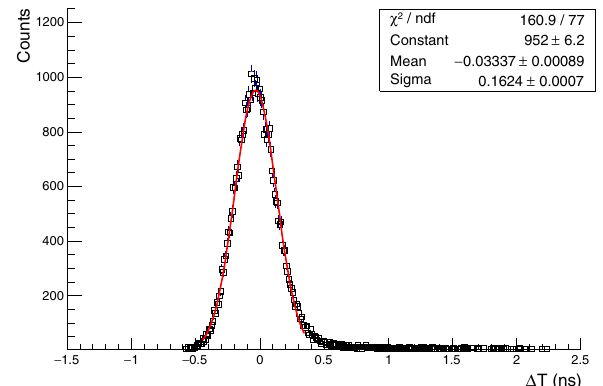
Fig. 14 Simulated distribution of T MRPC − Tr0 with proton beam. The beam momentum uncertainty and Tr0 timing jitter are included